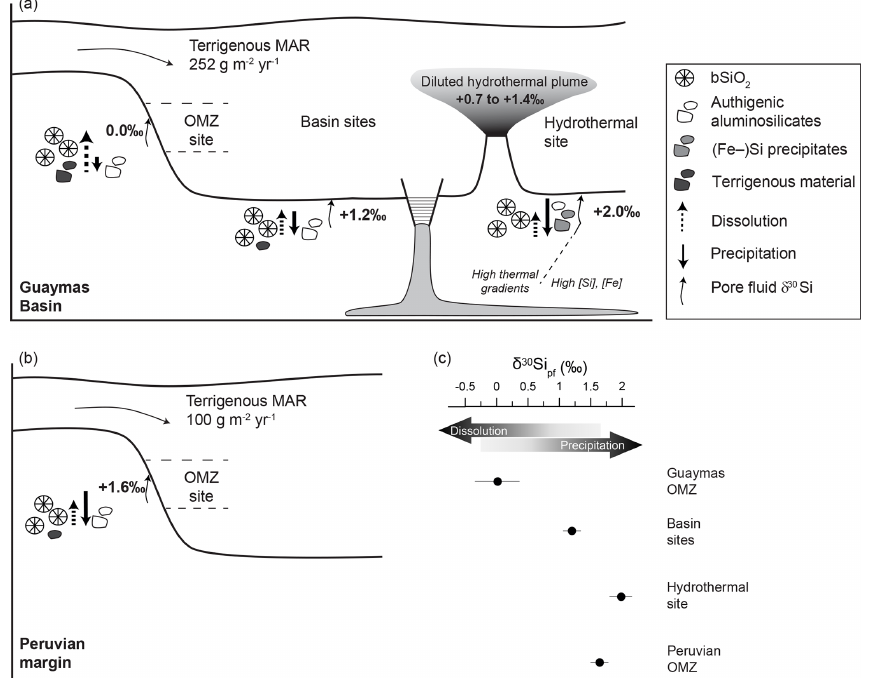
Figure 5. Conceptual model of the processes influencing pore fluid δ 30 Si pf values in the Guaymas Basin (a) and the Peruvian margin following Ehlert et al. (2016) (b) . Bold values in the sediment show the average pore fluid δ 30 Si pf values. Arrow length indicates the dominating process (dissolution versus precipitation). The δ 30 Si values in the hydrothermal plume indicate dilution with seawater (see Sect. 4.5). (c) The average pore fluid δ 30 Si pf values are shown, indicating the dominance of precipitation or dissolution processes for the three settings in the Guaymas Basin and the Peruvian